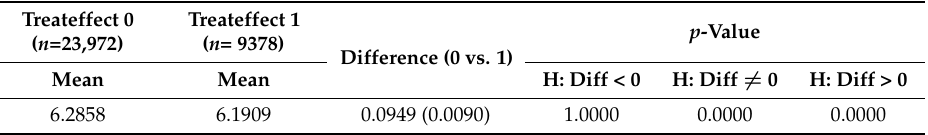
Table 4. Difference test of means in logarithm of hourly consumption by Treateffect variable. Treateffect 0 ( n =23,972)